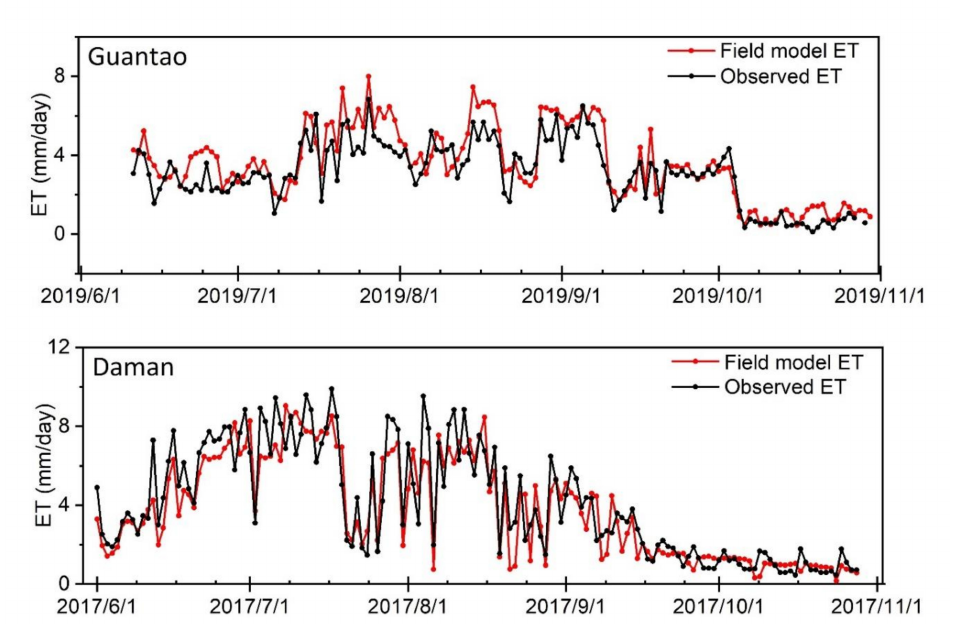
Figure 6. Temporal development of the field model ET at the two research stations. In each panel, the red line indicates the field model ET, and the black line indicates the site observed ET from the eddy covariance